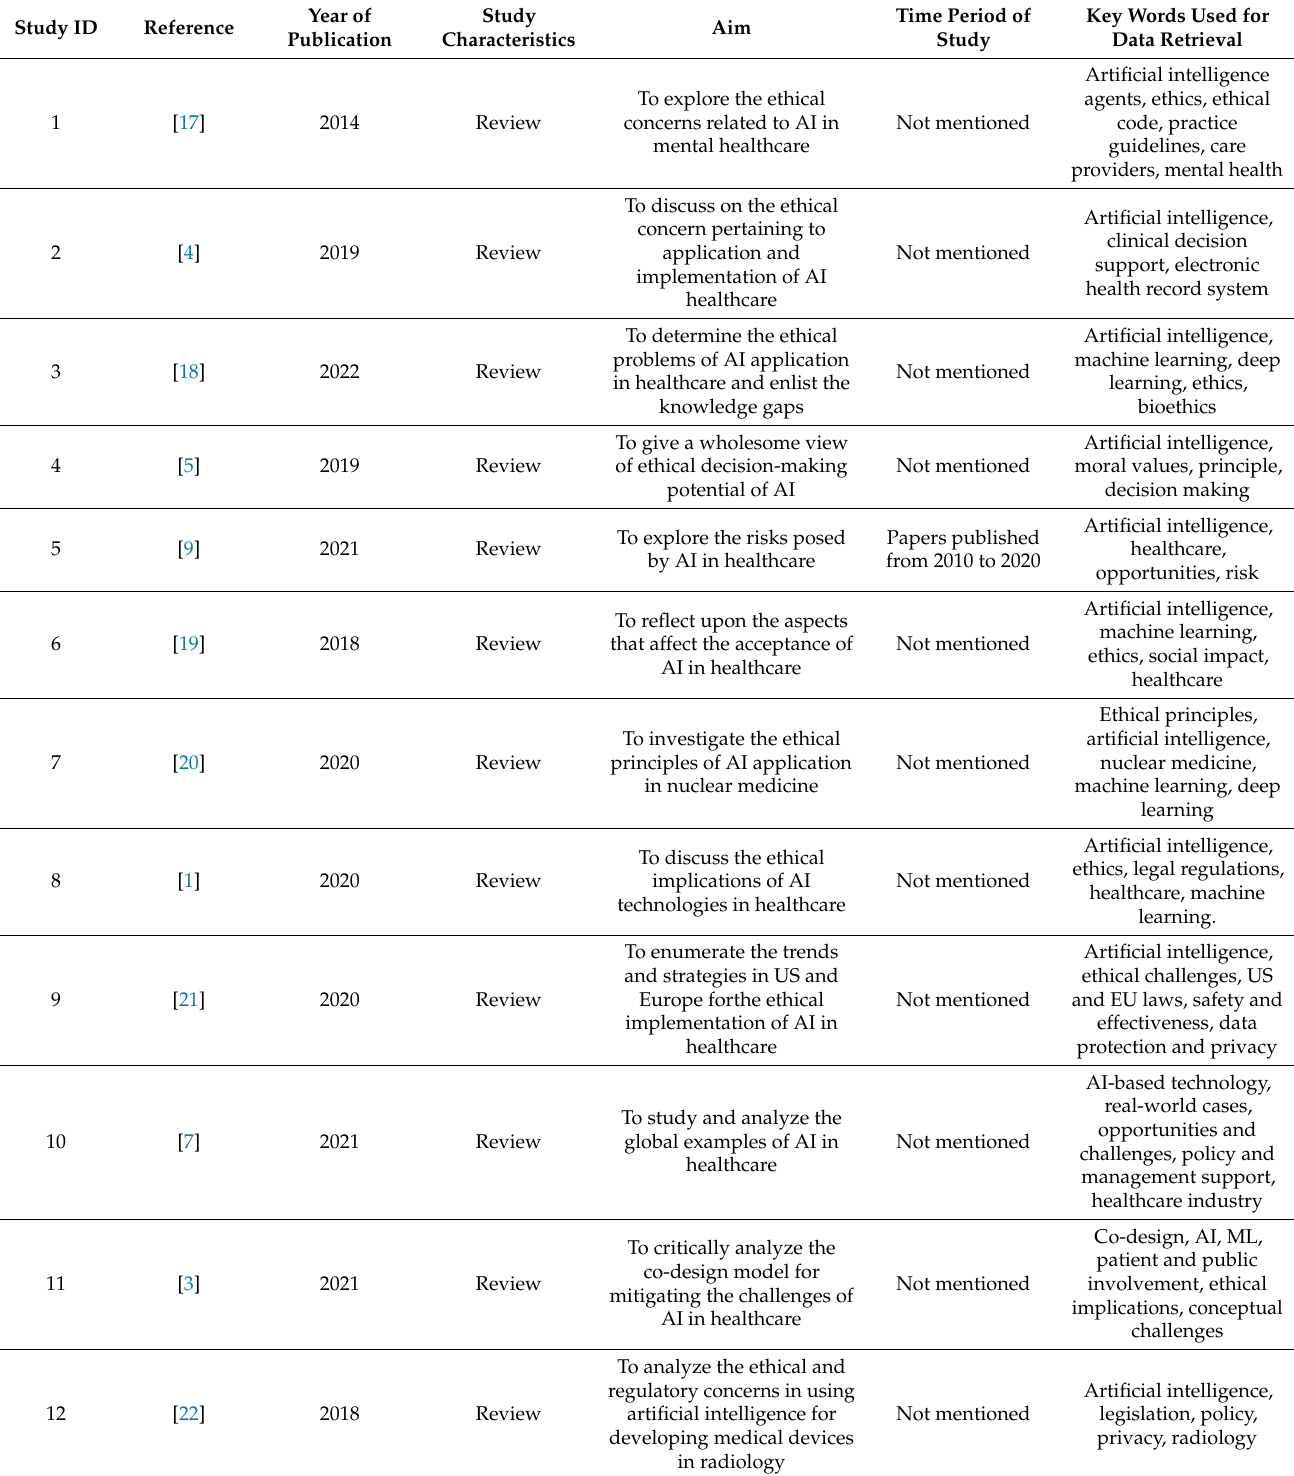
Table 2. Characteristics of data extracted for